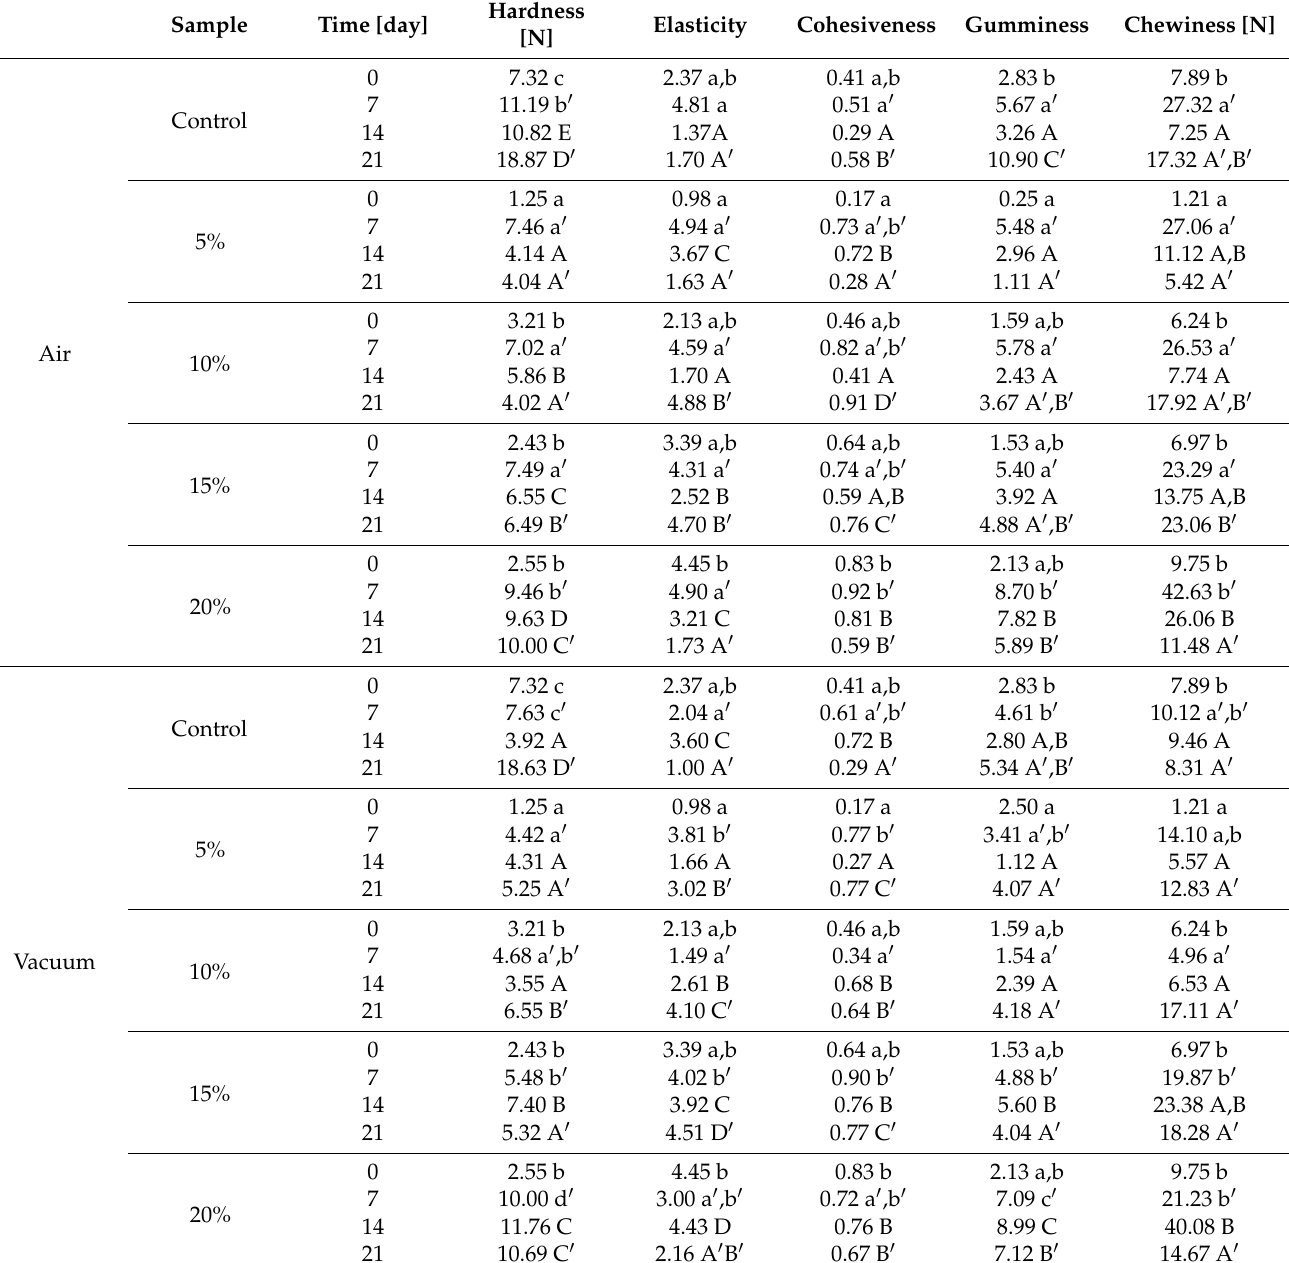
Table 4. Hardness, elasticity, cohesiveness, gumminess and chewiness of gluten-free bread with the addition of chestnut flour in the amounts of 0, 5, 10, 15 and